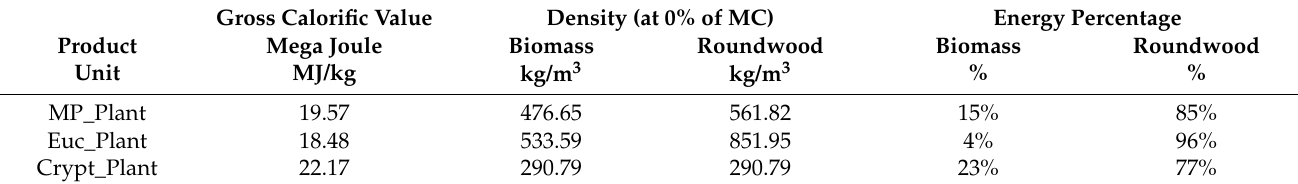
Table 9. Calculation of percentages of energy allocation.